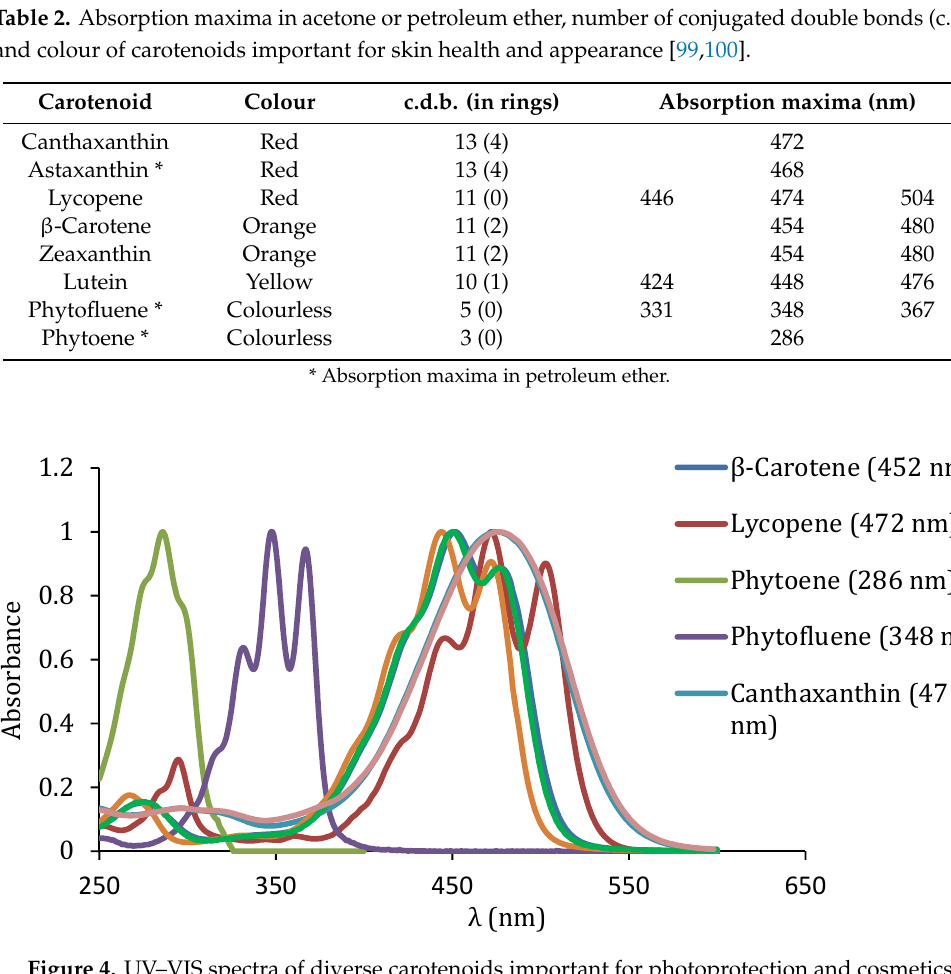
Figure 4. UV–VIS spectra of diverse carotenoids important for photoprotection and cosmetics.